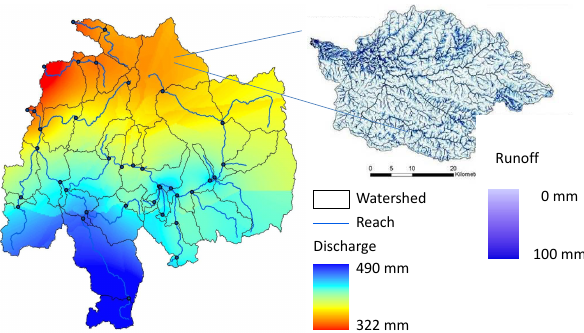
Fig. 8. Predicted average yearly spatial distribution of discharge in the Blue Nile Basin (main) and predicted runoff distribution in the Gumera sub watershed for an October 1997 event